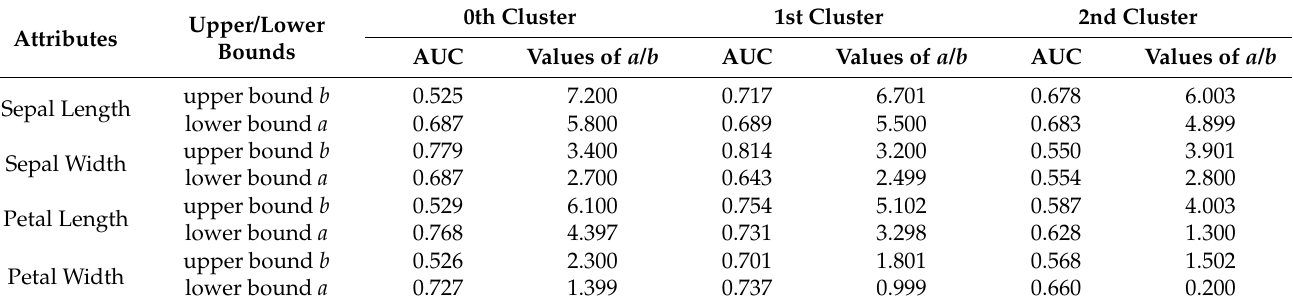
Table 3. The summary of the AUC values and optimized bounds of information granules ( α 1 = α 2 = 0.5).